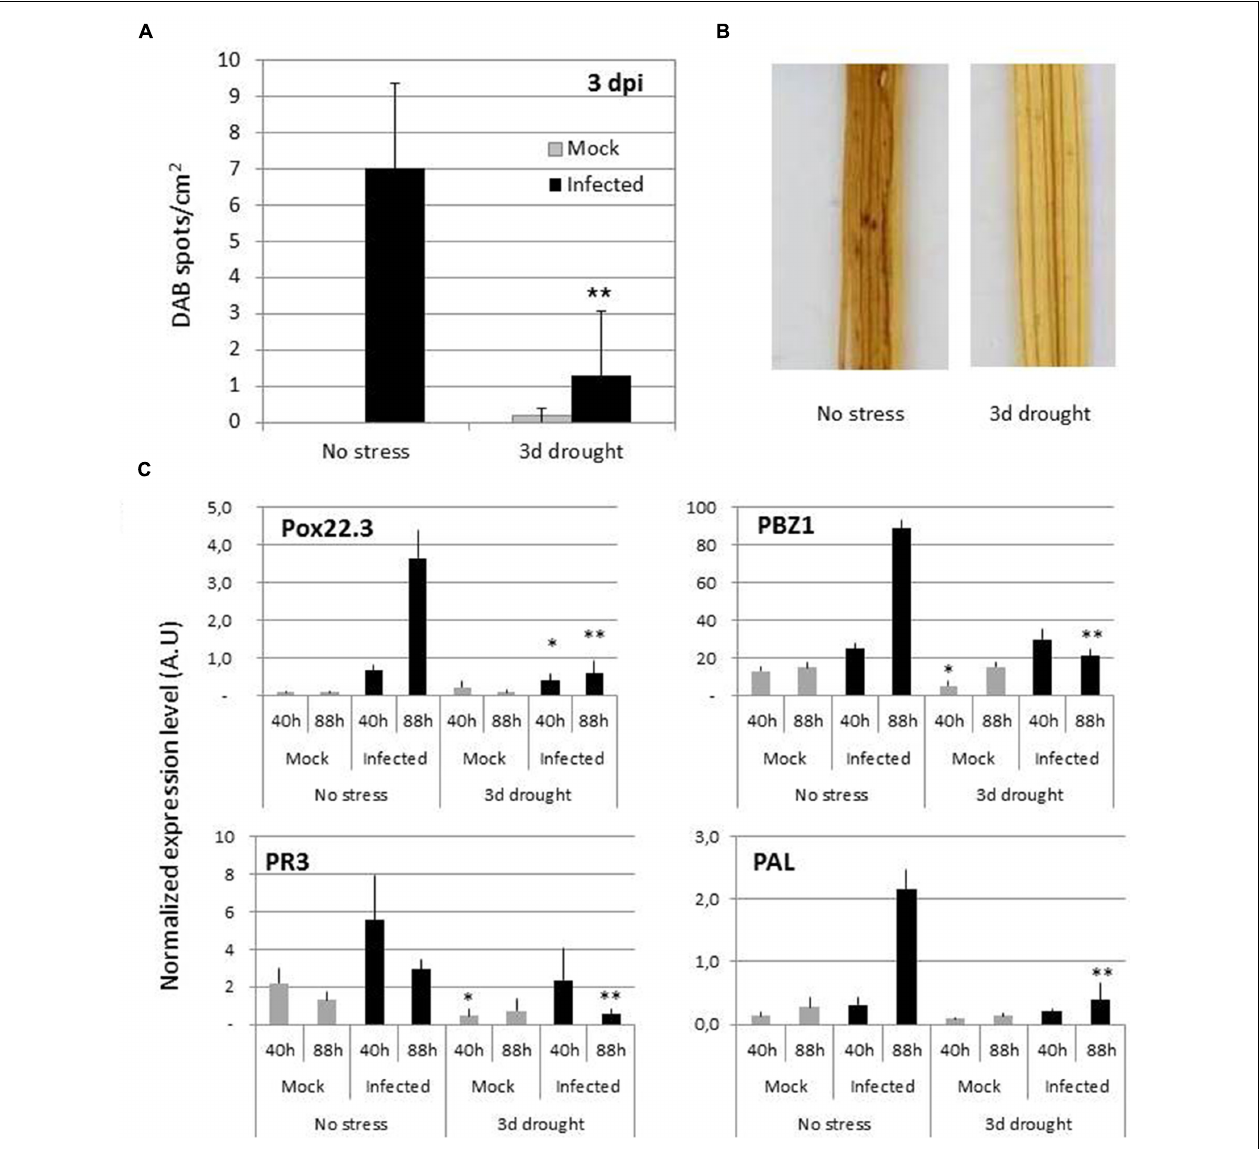
FIGURE 3 | Oxidative burst and transcriptional response of rice to M. oryzae infection after drought. The oxidative burst (A,B) and the expression of defense-related genes (C) was measured in Nipponbare plants inoculated as in Figure 1 after 3-days drought. Plants were spray inoculated with M. oryzae fungus (Guy11) or mock treated (0.5% gelatine). (A,B) DAB staining was used to visualize oxidative burst in plants at 3 dpi. A t -test was used to compare gene expression in non-stressed and drought stressed plants ( ∗∗ P < 0.01). (C) Expression of the disease responsive marker genes was measured by RT-qPCR and normalized to rice Actin. The values are the mean and SD from four replicates. For each time point, a t -test was used to compare gene expression in non-stressed and drought stressed plants ( ∗∗ P < 0.01; ∗ P < 0.05).